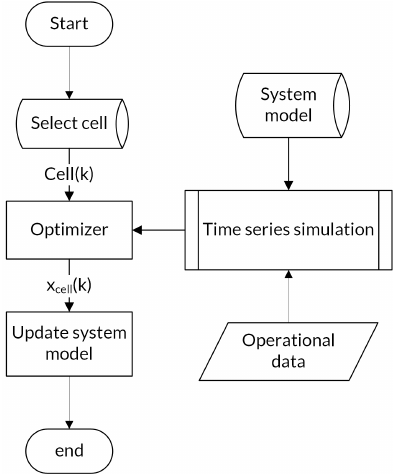
Figure 5. The implemented algorithm for cell level